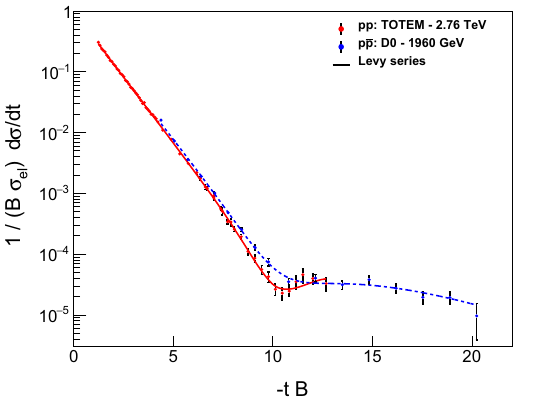
d σ of the differential (red), as compared to elastic pp collisions at √ B σ el dt On both panels, statistical errors and t -dependent systematic errors are s = 2 . 76 TeV LHC (red), as added in quadrature. Lines are shown to guide the eye, corresponding to fits with the model-independent Lévy series from Refs. [9,26] √ s = 7 TeV